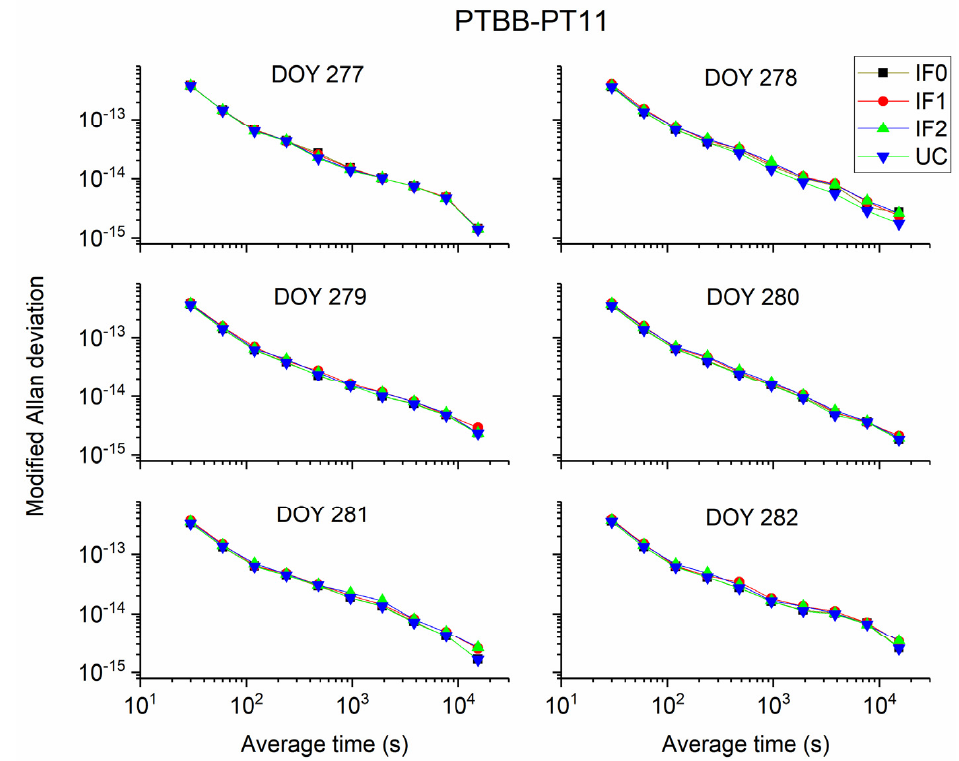
Figure 12. Comparison of MDEV between different Galileo PPP models for PTBB-PT11.